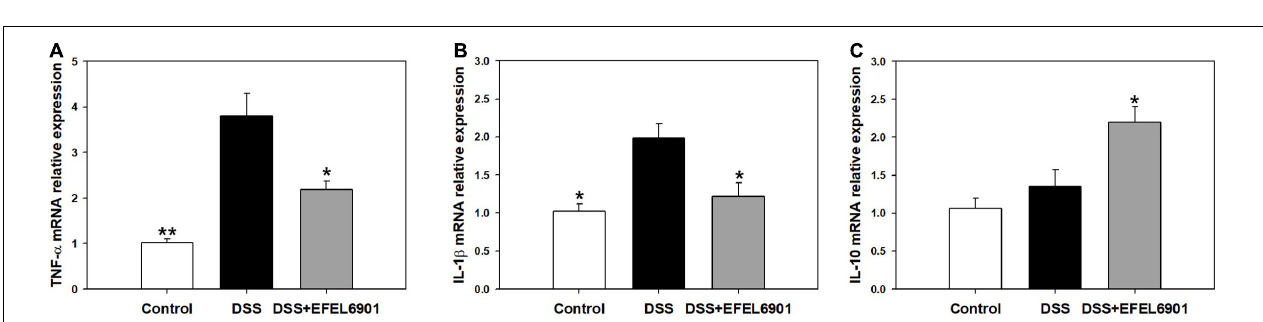
FIGURE 5 | Effects of Limosilactobacillus reuteri EFEL6901 strain on tight junction protein levels in mouse colon. (A) Representative western blotting of E-cadherin, occludin, claudin-3, and β -actin (loading control). Quantification of E-cadherin (B) , occludin (C) , and claudin-3 (D) protein expression levels in the colon. Results are expressed as means ± standard error ( n = 7). Significant differences are presented with the DSS group: * p < 0.05; ** p < 0.01.